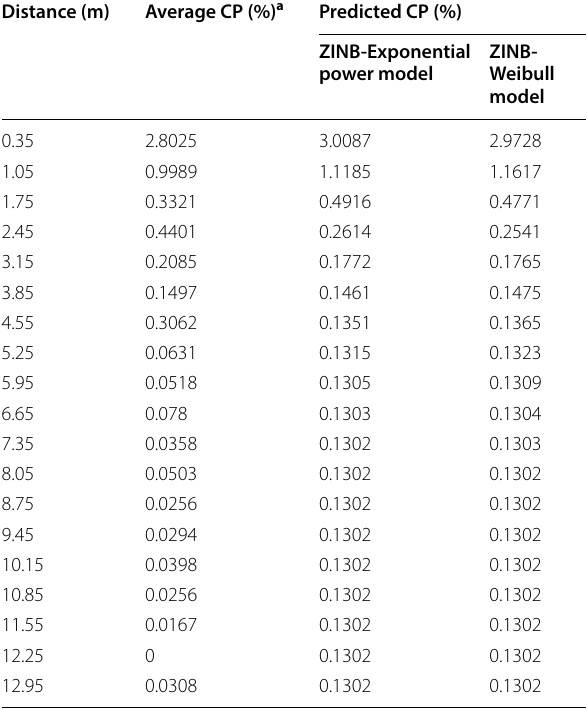
CP: cross-pollinated rate a Average cross-pollinated rate of the validation dataset